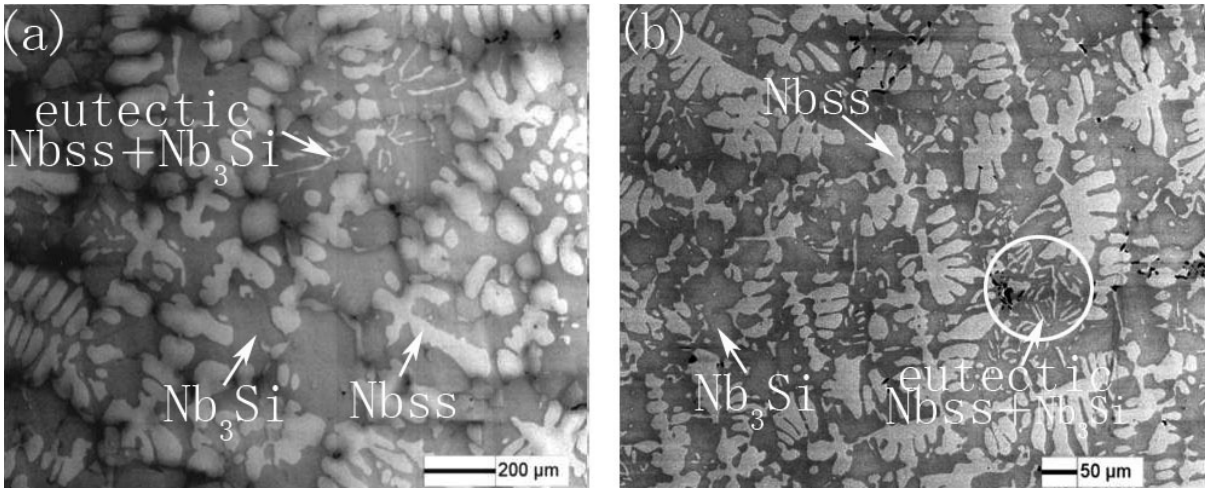
Figure 4. Microstructures of HT samples: (a) HT1.2; (b)